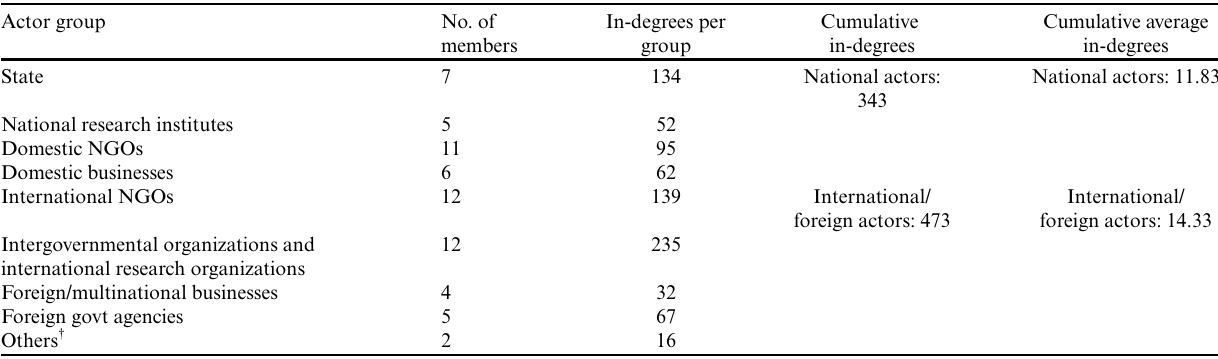
Table 1 . In-degrees of each actor group, indicating their perceived influence. Actor group